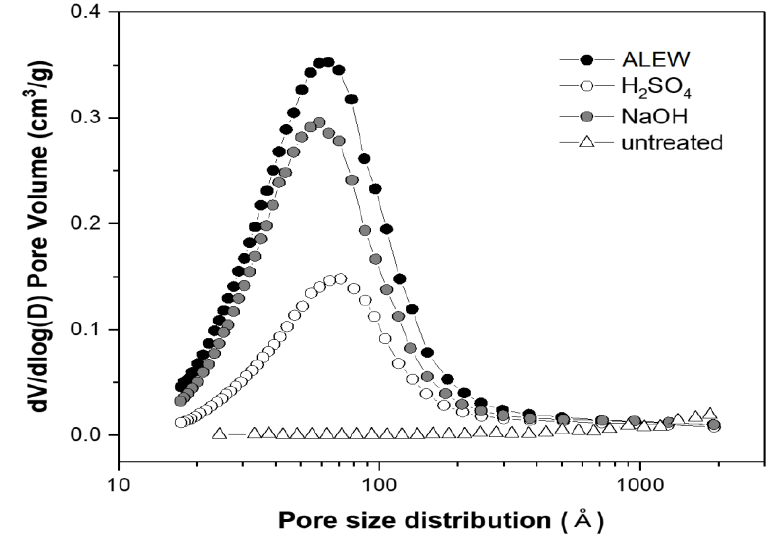
Figure 5. Pretreatment method effects on the pore size distribution for the ALEW critical point dried Eucalyptus samples.